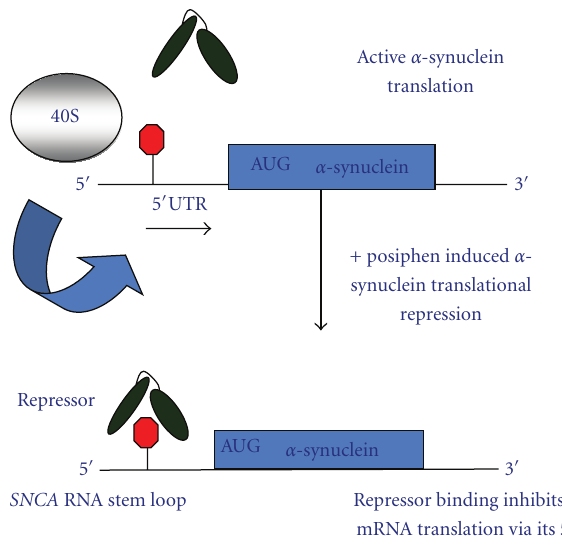
Figure 7: A model for translation repression of alpha-synuclein in which its transcript interacts with an RNA repressor protein. In the classical translation repression model, Iron-regulatory protein-1 (IRP1) controls iron dependent expression of the ferritin L- and H-chains. By analogy, phenserine, posiphen and its metabolic analogs would be predicted to increase the repressor as an RNA binding protein to interact with the SNCA 5 (cid:2) UTR after drug treatment. This should prohibit 40S ribosome access to the 5 (cid:2) UTR of SNCA mRNA to lower